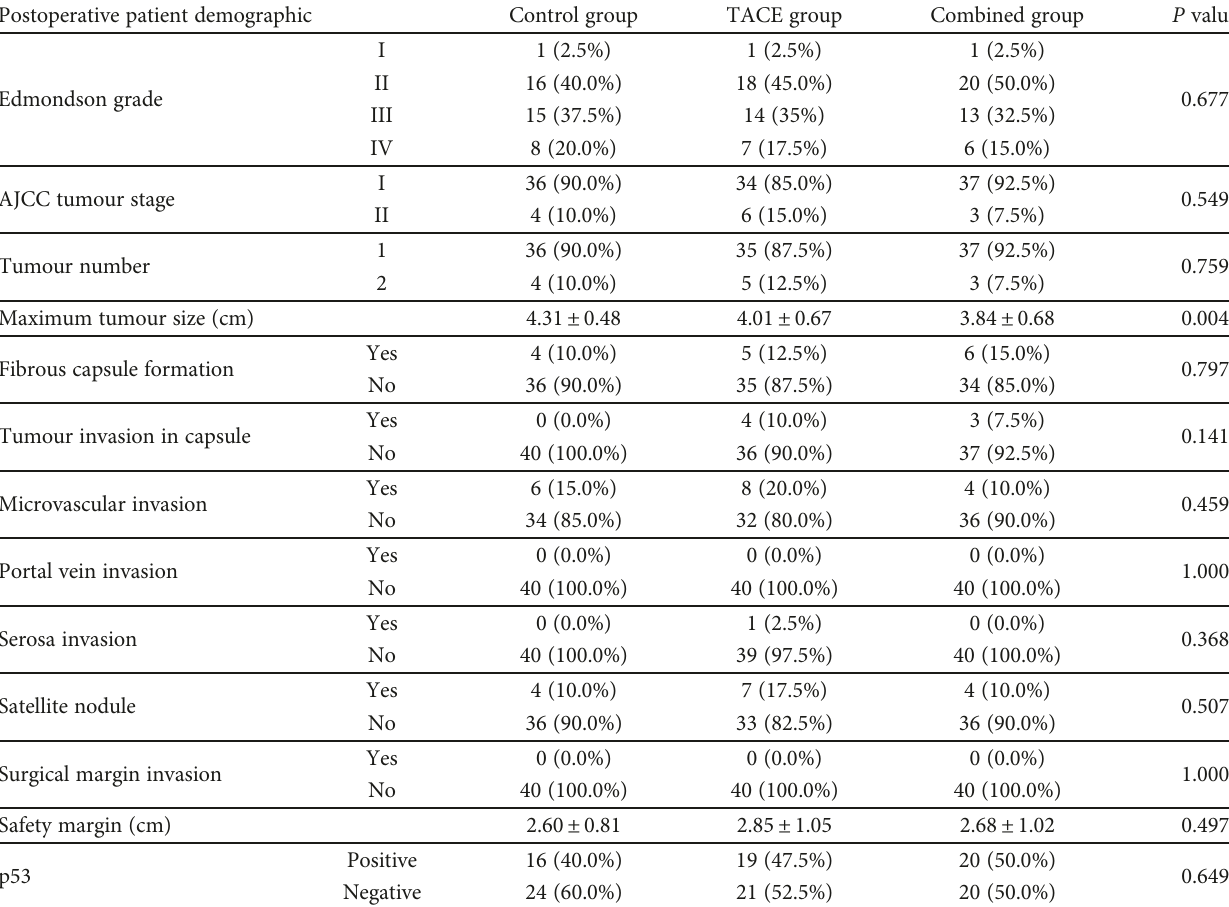
Table 2: Postoperative demographic characteristics of patients in the three